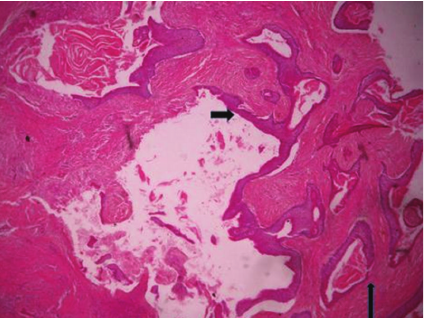
Figure 8: Photomicrograph showing a lining epithelium which is 6–8 cell layers thick, having basal cell palisading, surface parakera- tinisation, and keratin squames within the lumen; there is artifactual separation of the lining epithelium from the connective tissue wall (short arrow). Also seen are other smaller cysts having a similar lining and containing keratin (long arrow) ( × 50).